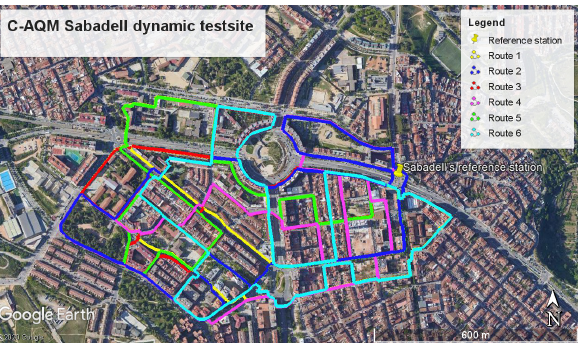
Figure 4. Walking routes.